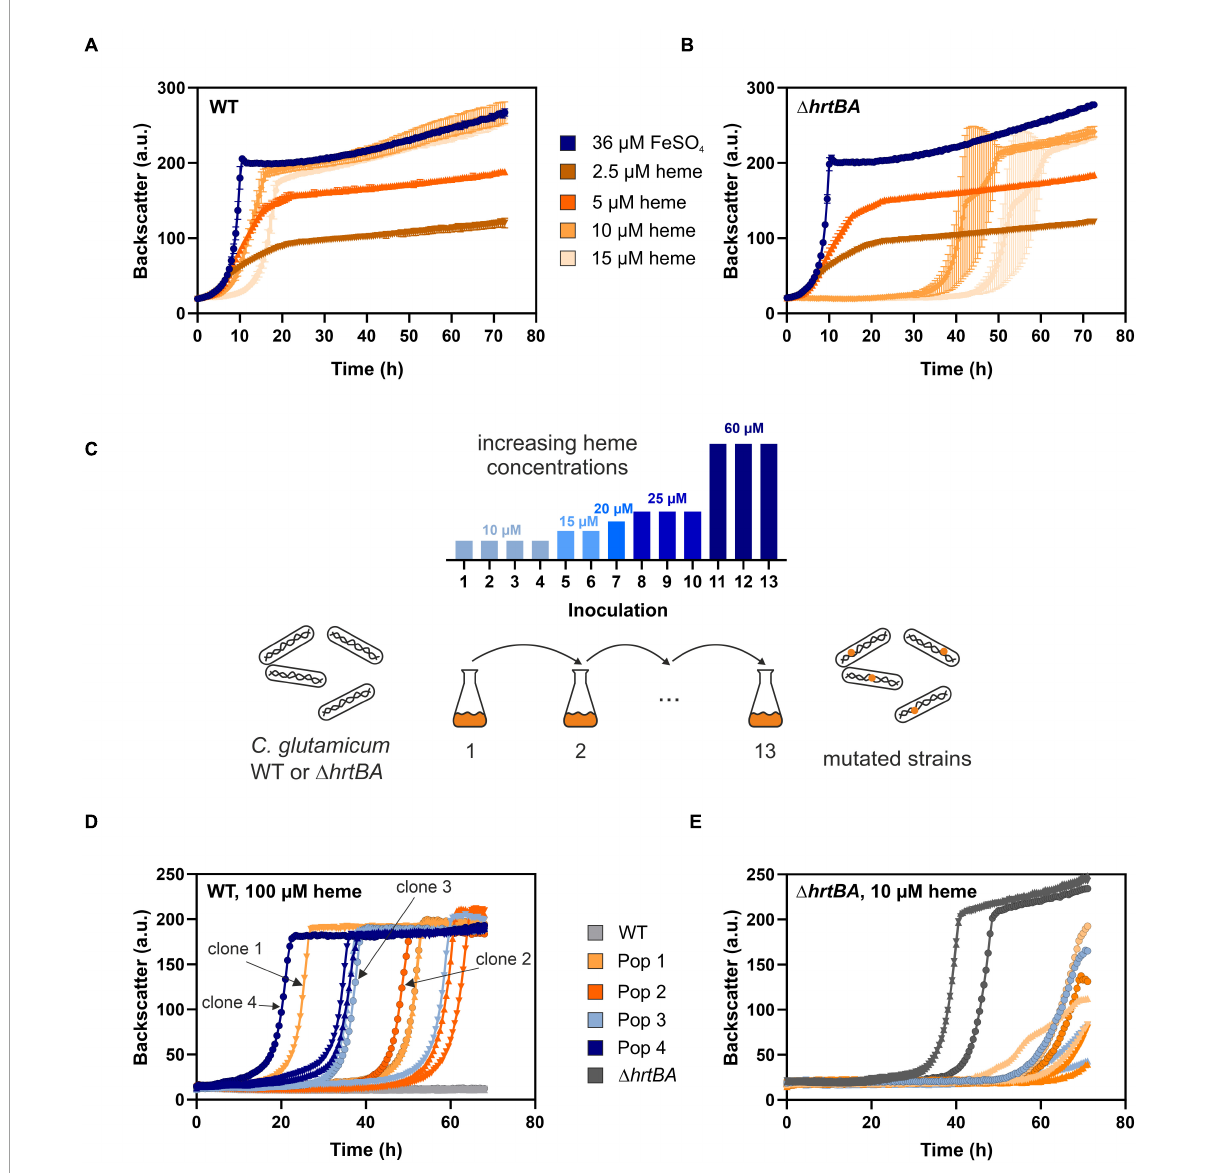
FIGURE2 Adaptive laboratory evolution of C. glutamicum to high heme levels. The C. glutamicum wild type (WT) (A) as well as the (cid:49) hrtBA strain (B) were inoculated at a starting-OD 600 of 1 in CGXII medium containing 2% glucose and either 36 µ M iron (blue) or increasing concentrations of heme (2.5–15 µ M, shades of orange). Data represent the average of three biological replicates including standard deviations depicted as error bars. (C) Schematic representation of the adaptive laboratory evolution (ALE) experiment. The heme concentration was increased from 10 to 60 µ M heme for the WT in overall 13 repetitive batch cultures (depicted in the bar graph). For the (cid:49) hrtBA strain, concentrations > 15 µ M remained toxic throughout the experiment and therefore were not further increased. (D) Growth of each three single clones derived from four different evolved C. glutamicum wild type populations on 100 µ M heme. (E) Growth of each three single clones of the three evolved (cid:49) hrtBA populations on 10 µ M heme.